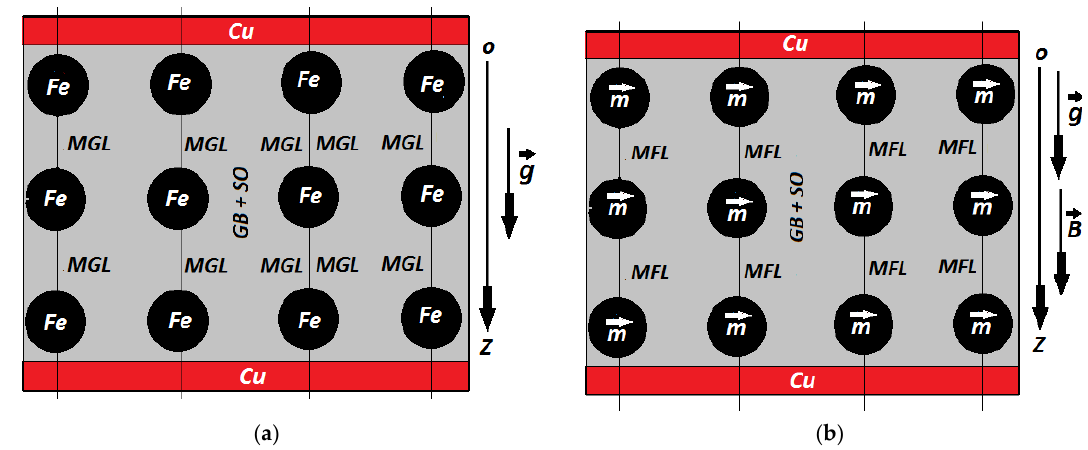
Figure 5. Cross-sections through capacitor CM in ( a ) gravitational field (model) and ( b ) gravitational field and static magnetic field (model). Fe, iron microparticle; MGL, gravitational field line; GB + SO, cotton fiber fabric impregnated with SO oil; Cu, copper electrode; g , gravitational acceleration vector; Oz, coordinate axis; B , static magnetic flux density vector; m , magnetic moment vector; MFL, magnetic field line superimposed over gravitational field